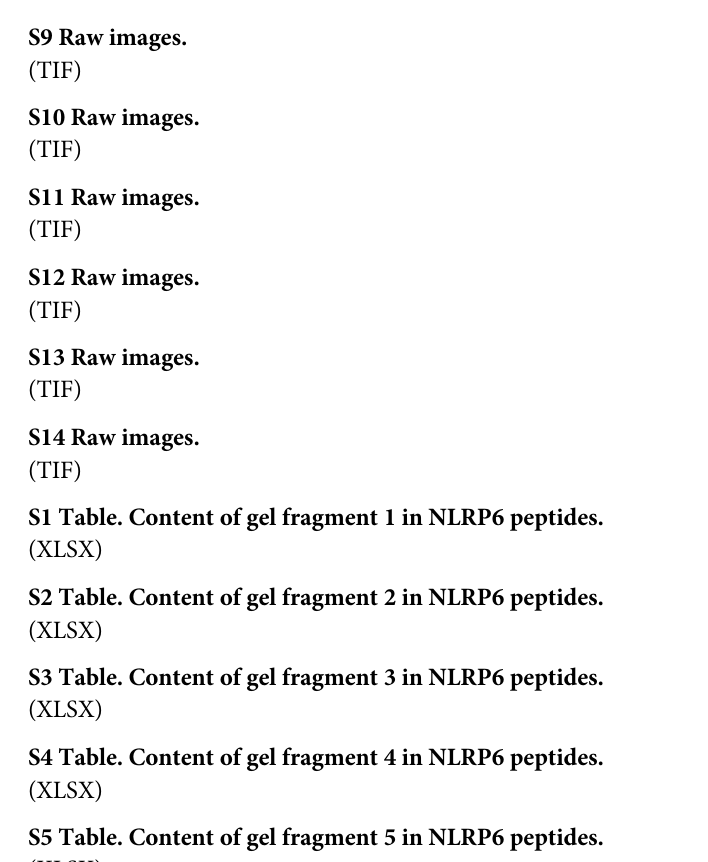
S1 Table. Content of gel fragment 1 in NLRP6 peptides. S2 Table. Content of gel fragment 2 in NLRP6 peptides. S3 Table. Content of gel fragment 3 in NLRP6 peptides. S4 Table. Content of gel fragment 4 in NLRP6 peptides. S5 Table. Content of gel fragment 5 in NLRP6 peptides. S6 Table. Content of gel fragment 6 in NLRP6 peptides. S7 Table. The most abundant proteins in gel fragment 1 and 5. (XLSX) S1 File. Percentage of identity and similarity between the sequence of the NLRP6 peptide used as immunogen by ABGENT. The sequence of the synthetic peptide corresponding to amino acids 168 to 197 of the human NLRP6 used as immunogen was aligned against the sequence of human HSP90